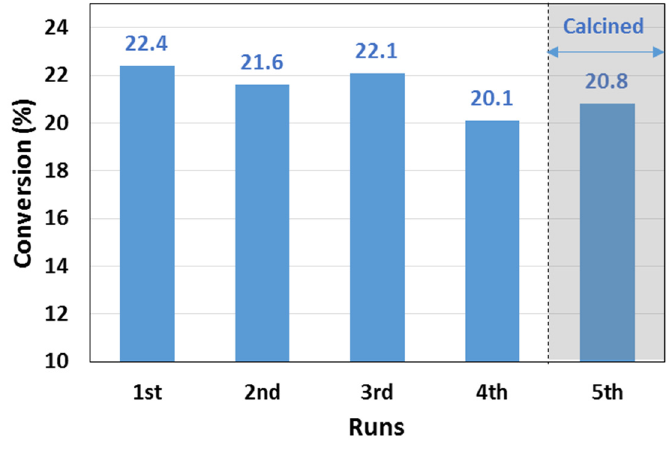
Figure 13. The cyclohexene conversion % over the same samples of Pt-ZSM-5 for four consecutive runs without treatment and one run after thermal treatment (calcination).